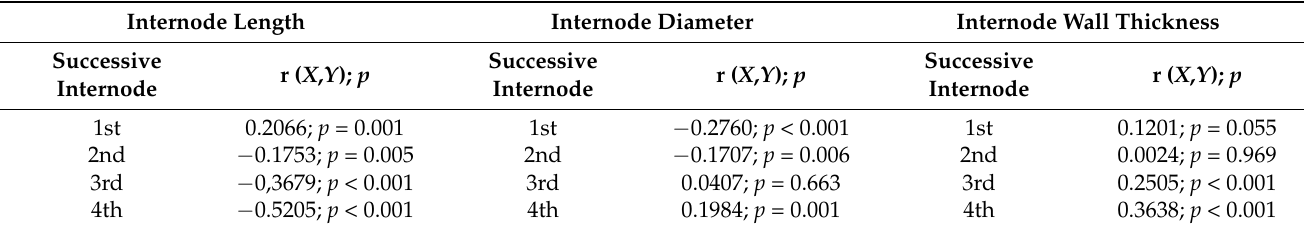
Table 6. Relationship (correlation coefficient) between lodging index (canopy height to tiller length ratio) at ripening and length, diameter, and a wall thickness of successive internodes of red fescue ( Festuca rubra ssp. rubra cv. Nista and F . r . ssp. commutata cv. Dorosa). Internode Length Internode Diameter Internode Wall